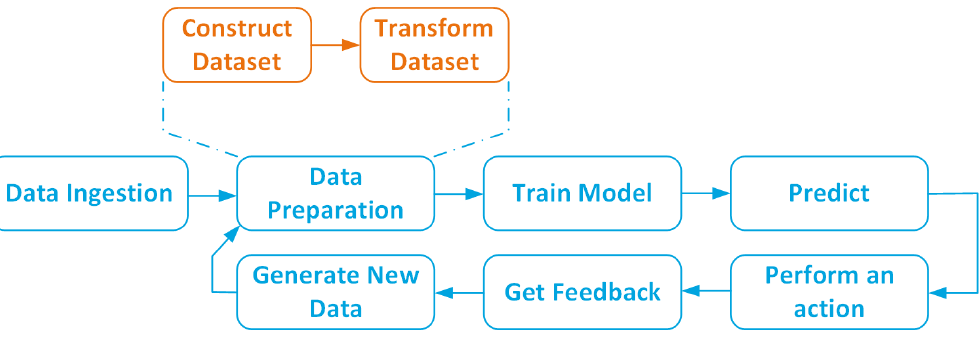
Figure 2. Typical ML